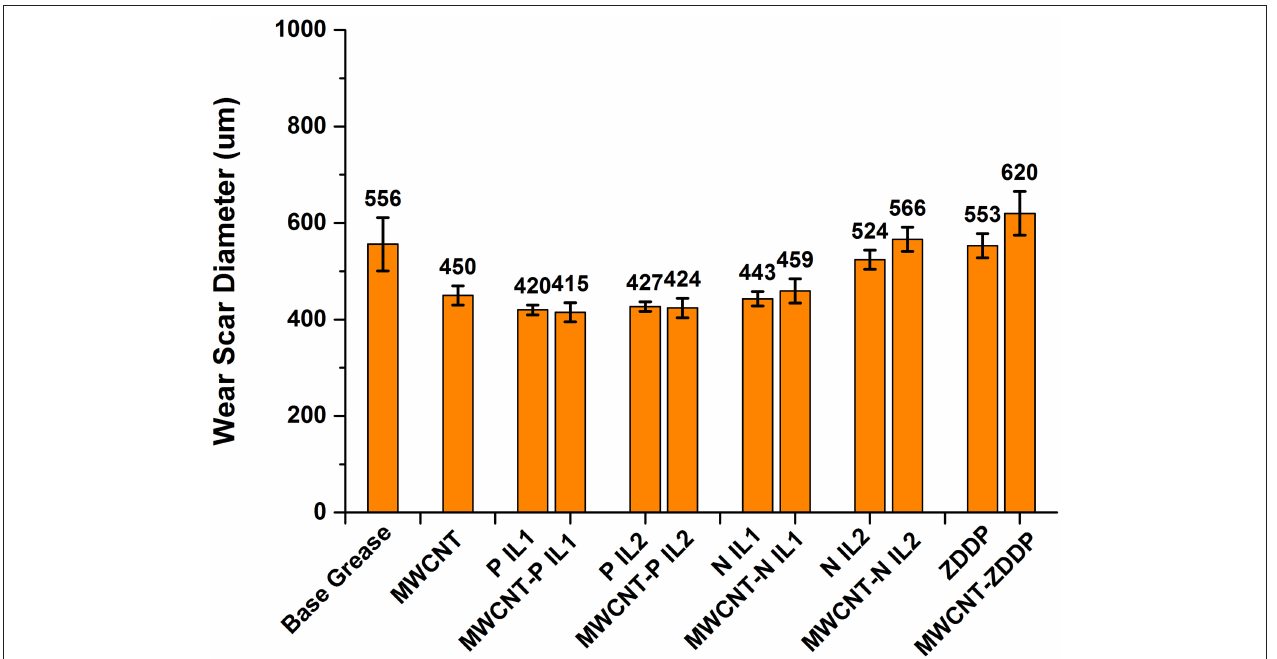
FIGURE 7 | Wear scar diameter from four ball wear tests for greases with MWCNT and ILs additives compared with base grease and MWCNT_ZDDP grease blends.